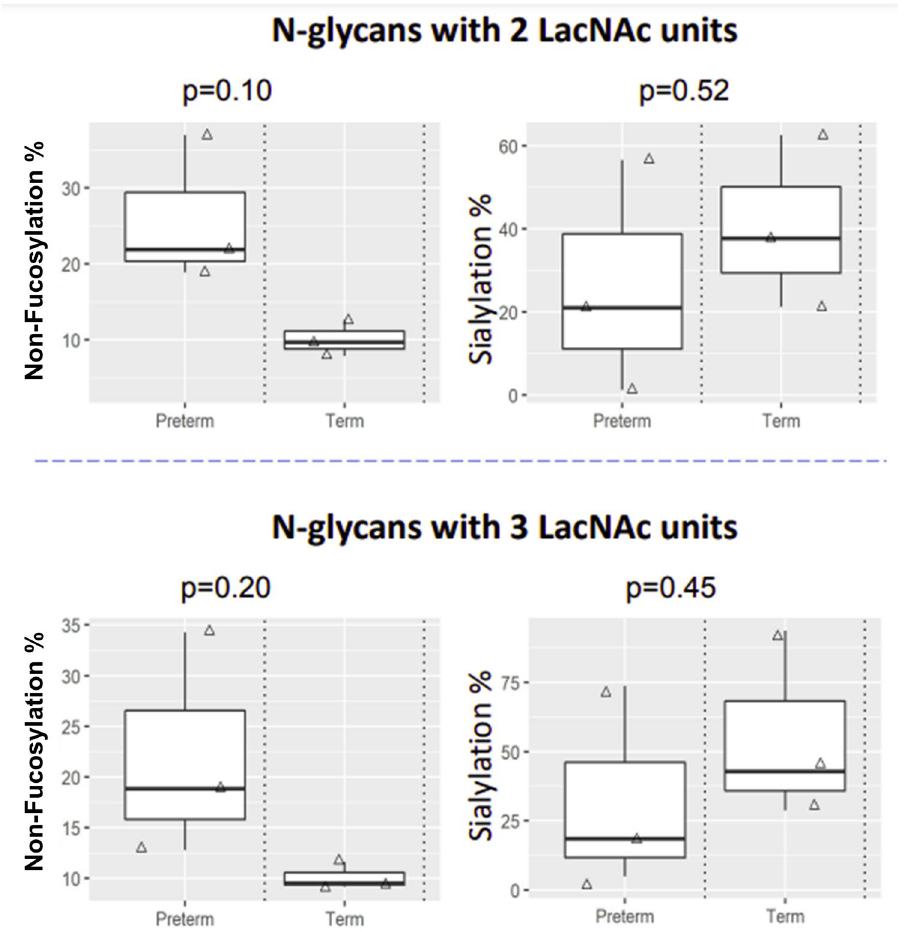
Figure 5. Fucosylation and sialylation variations between preterm and term samples. N-glycans with 2 LacNAc units (top panel) and 3 LacNAc units (bottom panel) from pregnant samples were selected for analysis. Non- fucosylation % was calculated as the relative intensity of non-fucosylated glycans to the intensity of all glycans. Sialylation % was calculated as the relative intensity of sialylated glycans to the intensity of all poly-fucosylated